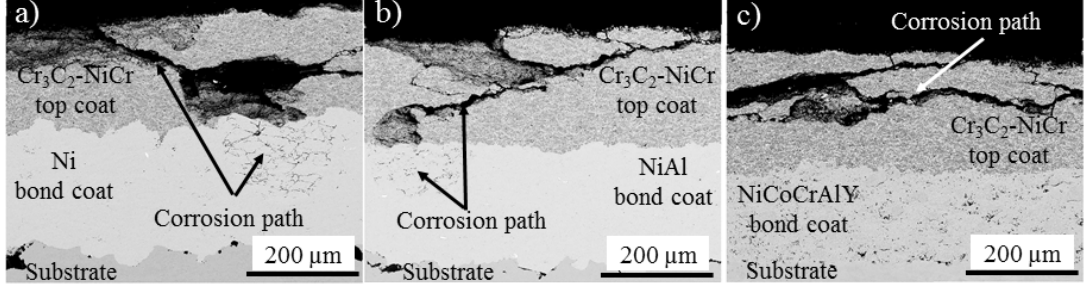
Figure 7. Microstructure of the corroded samples, ( a ) Ni/Cr 3 C 2 ‐ NiCr, ( b ) NiAl/Cr 3 C 2 ‐ NiCr and ( c ) NiCoCrAlY/Cr 3 C 2 ‐ NiCr [17]. (Reproduced from [18] with permission; Copyright 2016 Elsevier).